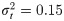
Performance of the identification under stronger PM signal (variance) σt2=0.15.p-value of the χ2 is plotted versus the amount of noise. Each curve represent a different number of sites from {50, 70, 100} (a) 50 individuals (b) 100 individuals.